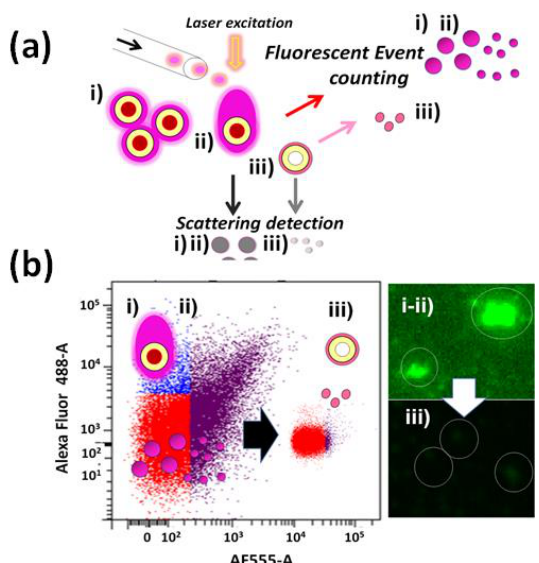
Figure 15. Enhanced nano-emitter detections: ( a ) scheme of in-flow detections of ultraluminescent gold core-shell nanoparticles (Au@SiO2-RhB NPs) and core-less nanoarchitectures ((–)@SiO2-RhB). Distributions of luminescent events of (i) small Au@SiO2-RhB nanoaggregates, (ii) single Au@SiO2-RhB detections, and (iii) core-less (–)@SiO2-RhB were collected, while variable scattered light (i,ii) from core-shell nanoparticles and (iii) from core-less structures was recorded. ( b ) In-flow cytometry by analysis of Alexa Fluor 488-A vs. AF555-A contour plots from core-shell NPs (i) and (ii) to core-less NPs. Inset images (i,ii) corresponded to detection of core-shell NPs and (iii) to core-less NPs by laser fluorescence microscopy. Reprinted with permission from ref. [136]. Copyright 2021, Elsevier.